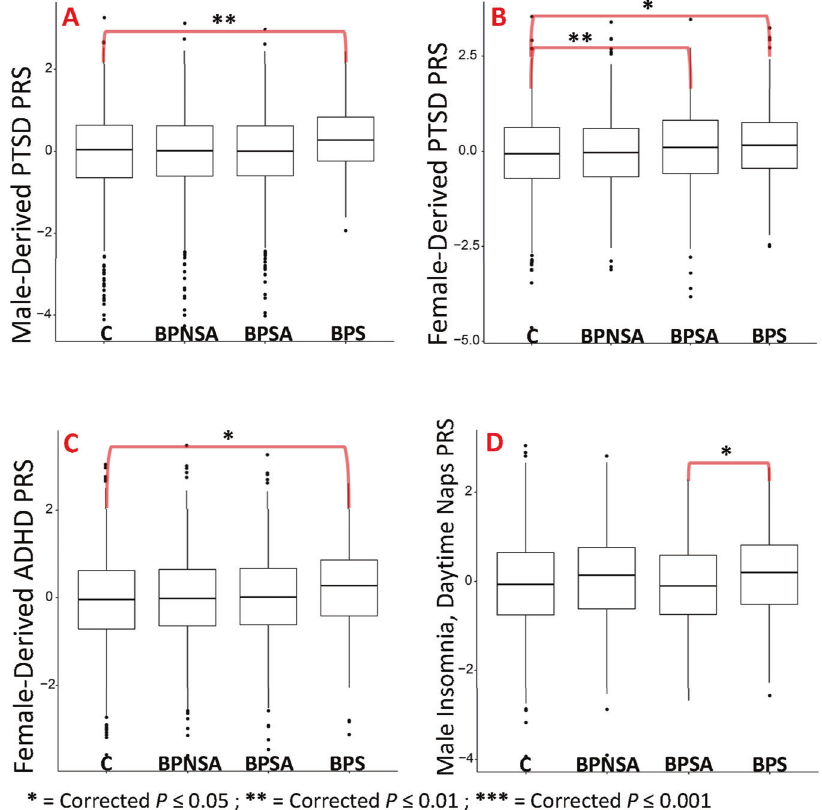
Fig. 4 PTSD and behavioral PRS results. Box plot representations of the top fi ndings from polygenic risk score association testing. Each plot represents comparison group ( x -axis) versus standardized polygenic risk score for the given phenotype ( y -axis). A Male-derived PTSD PRS. B Female-derived PTSD PRS. C Female-derived ADHD PRS. D Male only (sex-speci fi c) insomnia (daytime napping subgroup) PRS. Comparison group de fi nitions: BPS = individuals with bipolar disorder who died by suicide, BPSA = individuals with bipolar disorder who have a history of one or more suicide attempts, BPNSA = individuals with bipolar disorder who have no history of a suicide attempt, and C = comparison individuals without several common psychiatric illnesses per self-report [14]. Selected results shown; all displayed results have been corrected for multiple testing (Benjamini – Hochberg method with FDR of 0.05 correcting for 114 tests for A – C and 204 tests for D ) and account for critical covariates. Note that sex-derived refers to PRS calculated based on weighted results from the given sex in the original GWAS. All results were evaluated from all (male and female) subjects in the current study with the exception of D , which was an evaluation of only frequently diagnosed with insomnia despite a male-driven genetic fi nding, which may indicate sex-speci fi c differences in diagnosis or care seeking.